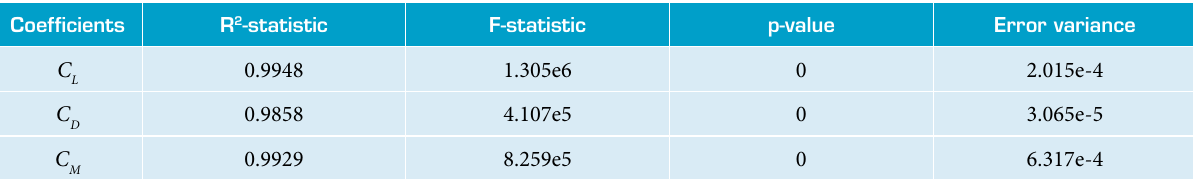
Table 2. Statistics of the fitting